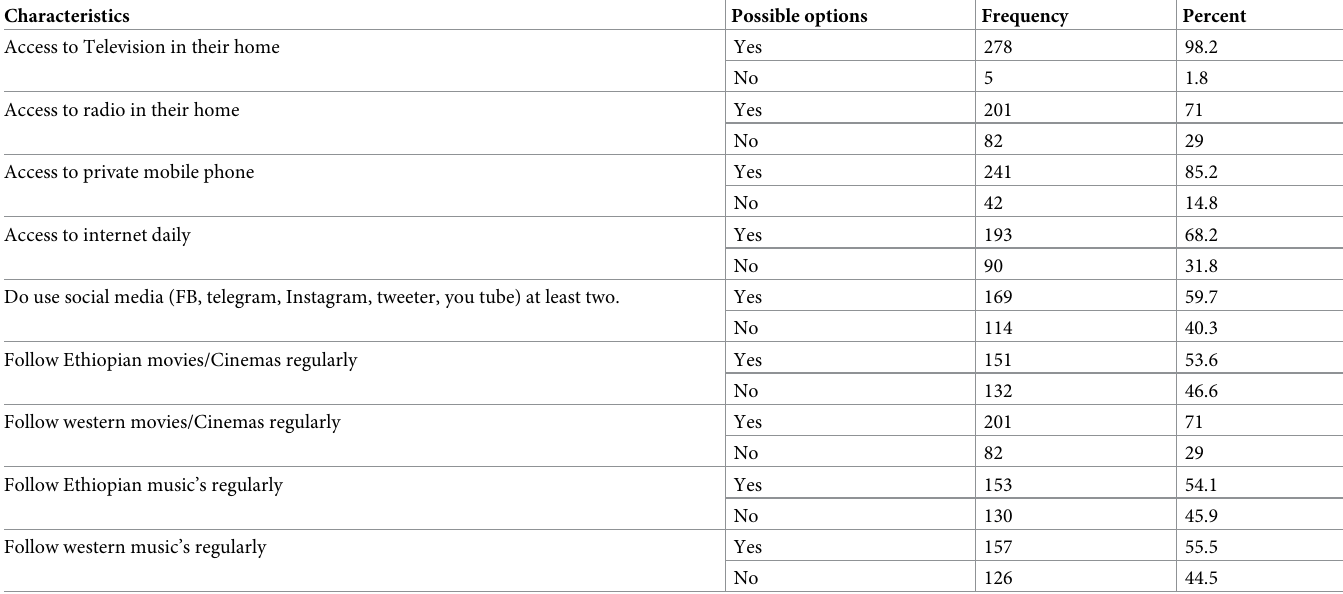
Table 5. Media access of adolescents in Addis Ababa city, Ethiopia.